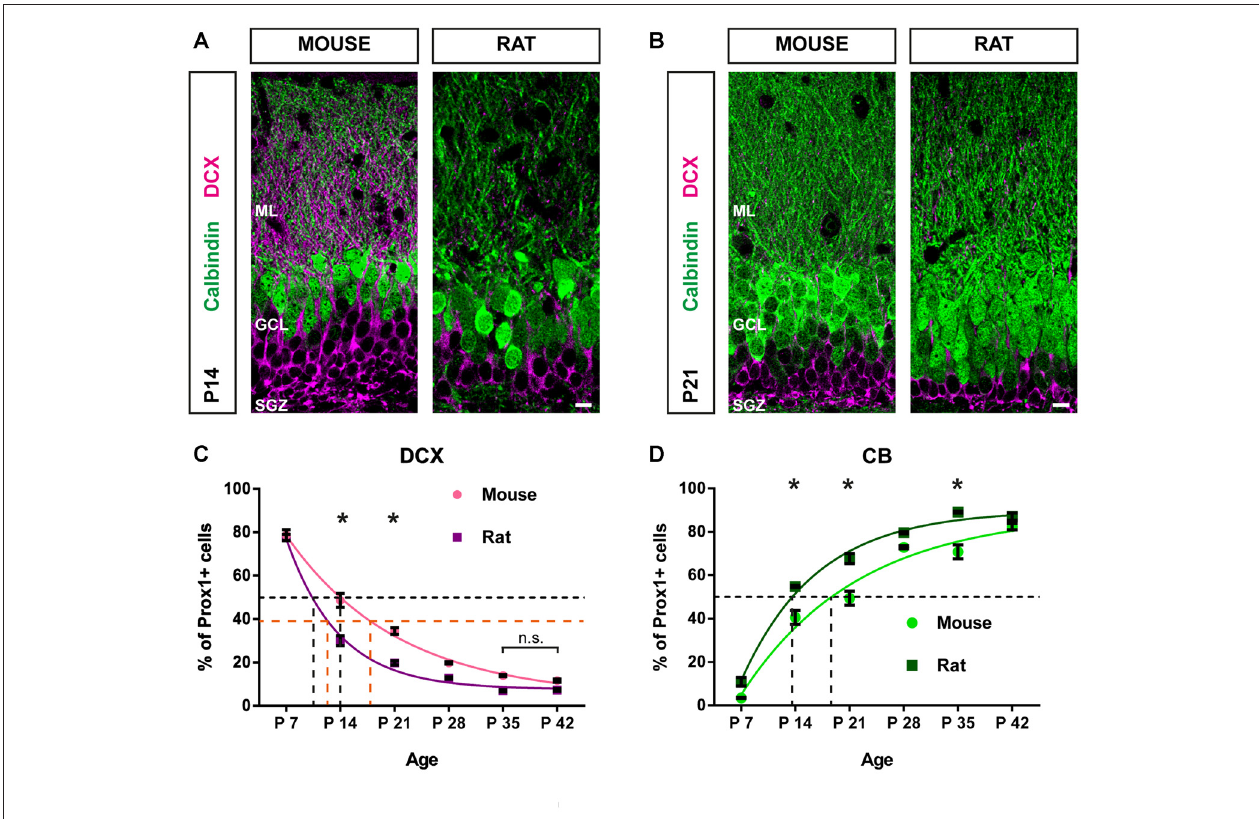
FIGURE 4 | Postnatal maturation of the DG progresses faster in the rat compared with the mouse. (A) Immunohistochemical depiction of DCX- (magenta) and CB-expressing GCs (green) in the mouse and rat DG at P14 and (B) at P21. (C) The comparison of DCX-positive GC distribution between mice and rats from P7 to P42 reveals that the proportion of DCX-expressing cells decreased more rapidly in the rat. Significant differences in the number of DCX-positive cells between species were found on P14 (two-way ANOVA with Bonferroni correction P < 0.05) and P21. There were no significant differences in the proportion of DCX-positive cells between P35 and P42 within groups, indicating that a steady state of DCX expression has been reached in both, mice and rats. A monoexponential fit was used to determine the average age at which 50% of Prox1-positive cells were DCX-positive (i.e., t 50%Prox1 ) in each species (black dashed lines). While for mice, t 50%Prox1 was at 14 days, in the rat, it was at 10 days. Furthermore, the time to half maximum decay of DCX expression from the first data point at P7 was determined for each species (i.e., t 50%DCX ). In mice t 50%DCX was at 18 days, whereas in rats, t 50%DCX occurred at 12 days (orange dashed lines). (D) The proportion of CB-positive GCs increased more quickly in the rat compared with GCs in the mouse. Significant differences in the number of CB-positive cells between species were found on P14 (two-way ANOVA with Bonferroni correction P < 0.05), P21 and P35. In the mouse t 50%Prox1 for Prox1-positive GCs expressing CB was 19 days, while in the rat, t 50%Prox1 occurred at 14 days (black dashed lines). These findings suggest that GCs mature faster in the rat compared with the mouse. Mouse: n P7 = 4; n P14 = 3; n P21 = 3; n P28 = 5; n P35 = 5; n P42 = 3. Rat: n P7 = 3; n P14 = 3; n P21 = 4; n P28 = 3; n P35 = 3; n P42 = 4. n = number of animals. Error bars represent SEM. ∗ P < 0.05. Scale bars: 10 µ